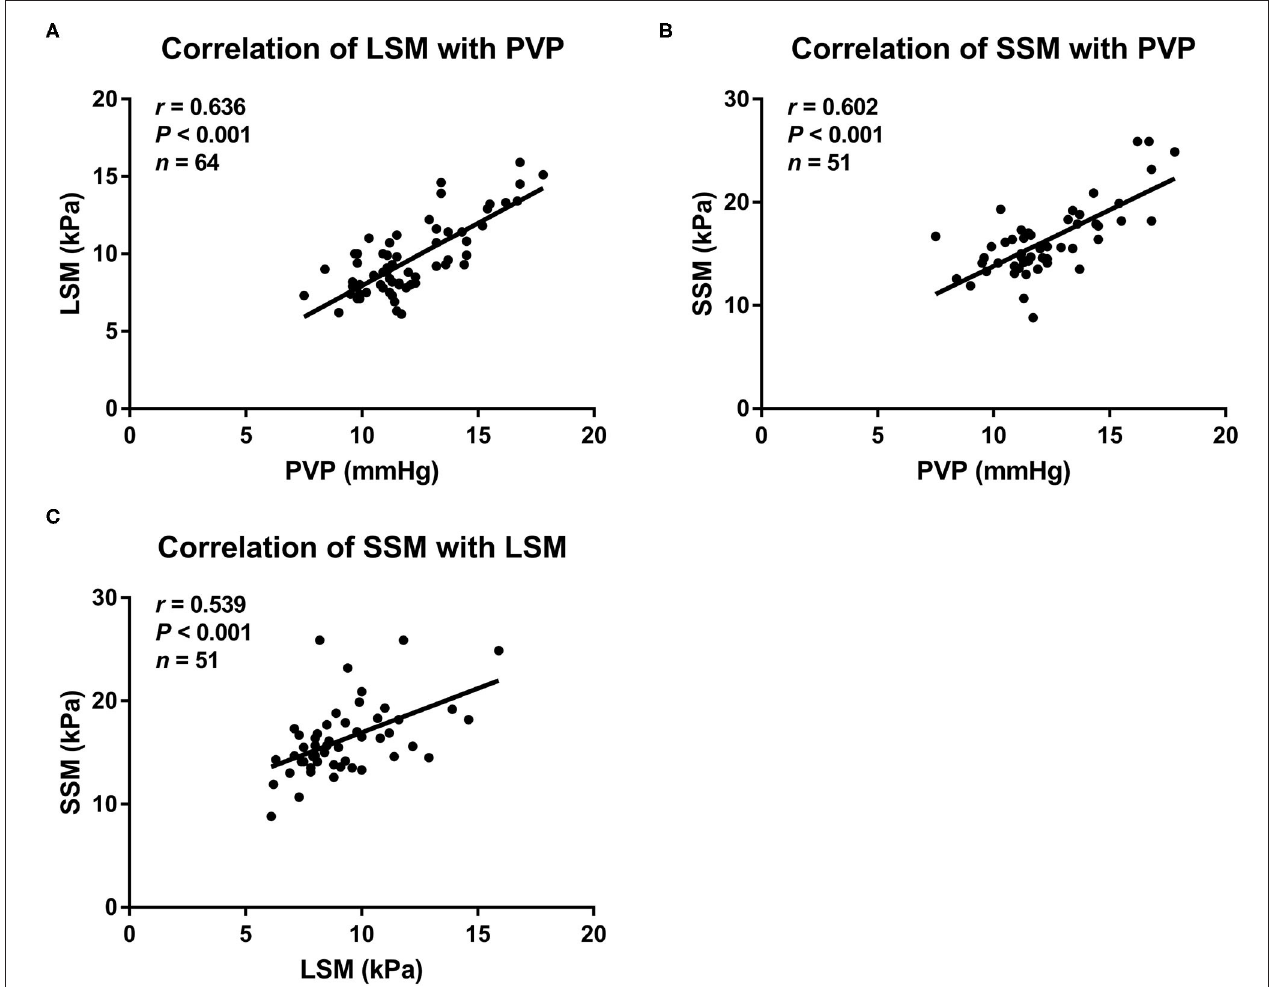
FIGURE 2 | Scatterplots showing correlations between (A) LSM, (B) SSM, and portal venous pressure, as well as (C) LSM with SSM in rat models with NAFLD. LSM, liver stiffness measurement; NAFLD, nonalcoholic fatty liver disease; PVP, portal venous pressure; SSM, spleen stiffness